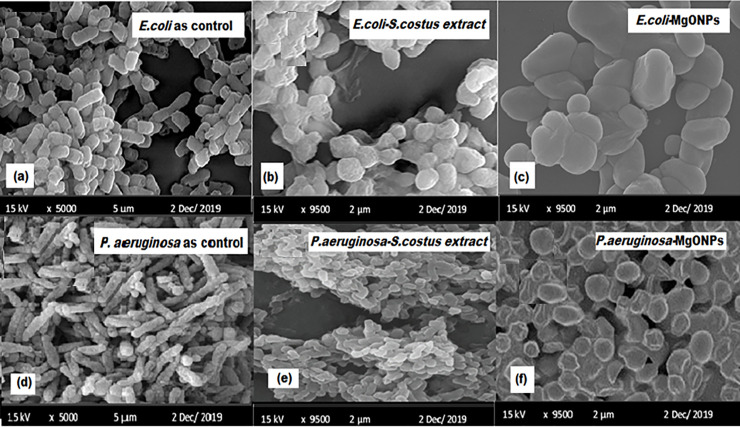
SEM images of untreated and treated with MgONPs (Qustal bahri) and altered shape of E. coli and P. aeruginosa.